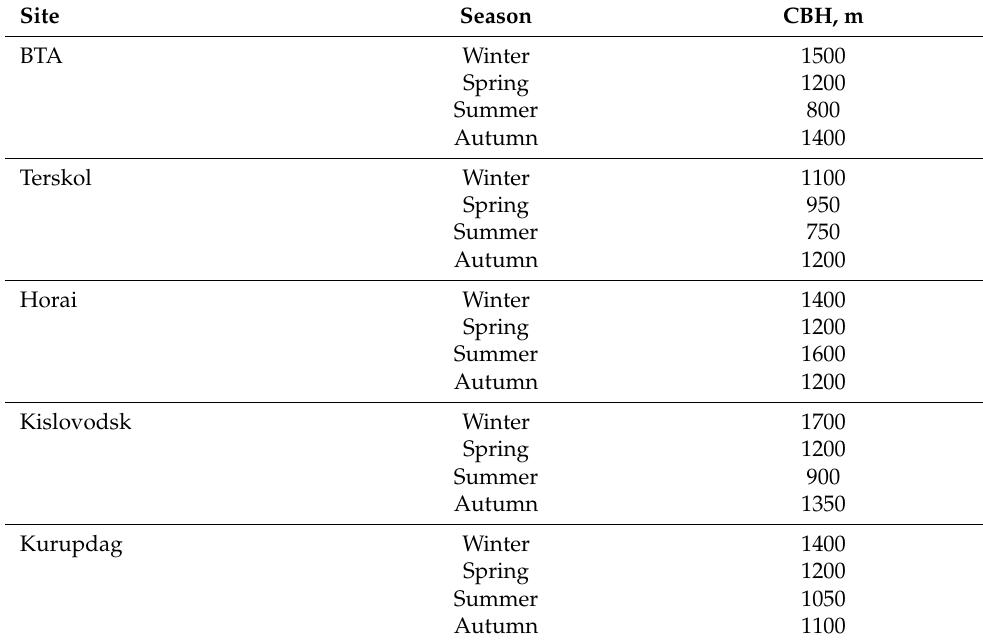
Table 4. Mean values of CBH at the sites suitable for mm/submm